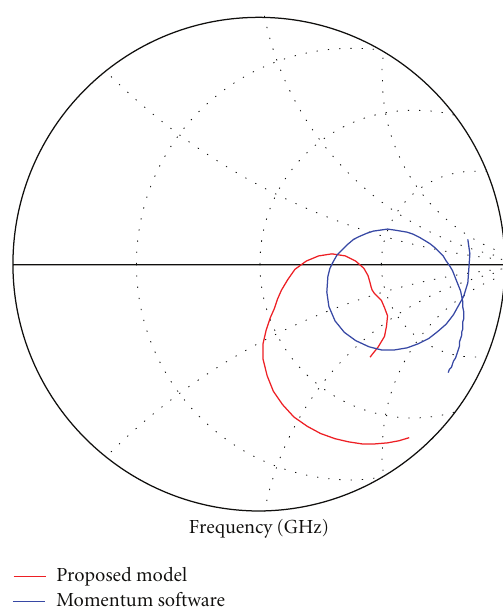
Figure 17: Smith’s chart of the input impedance return losses.